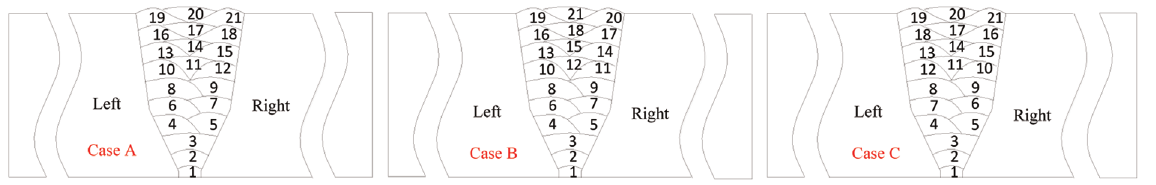
Figure 9: Different welding sequences.